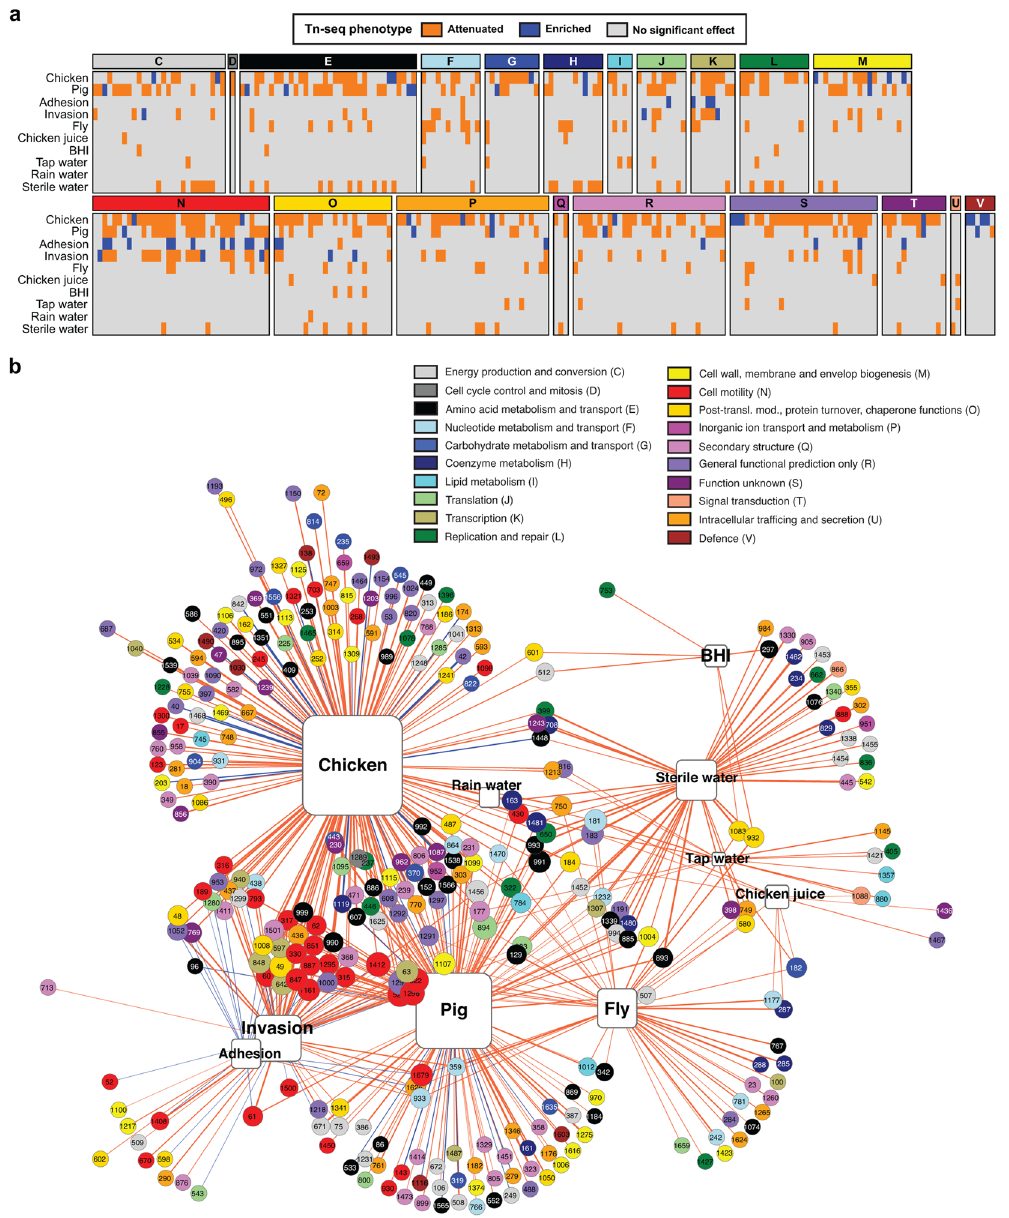
Figure 2. Identification of conditional essential genes in C . jejuni . ( a ) Effect of Tn insertions on the ability of C . jejuni M1cam to colonize commercial broiler chickens, infect gnotobiotic piglets, adhere and invade gut epithelial tissue culture cells, survive in flies and at 4 °C in various media (chicken juice, BHI, tap water, rain water, and sterile water). Genes of which Tn mutants showed significantly attenuated or enriched fitness in the experimental models are shown and are grouped according to their COG functional classification. Data represented as Log 2 fold-change is also presented in Table S4. ( b ) Gene-model interaction network showing attenuated (orange lines) and enriched (blue lines) Tn-seq scores linked to their respective models; the thickness of the connecting lines corresponds to the Log 2 fold-change (input/output). The gene numbers correspond to the C . jejuni M1cam locus-tags 13 and are color-coded according to their COG functional class. The size of the genes and the models displayed increases with the number of